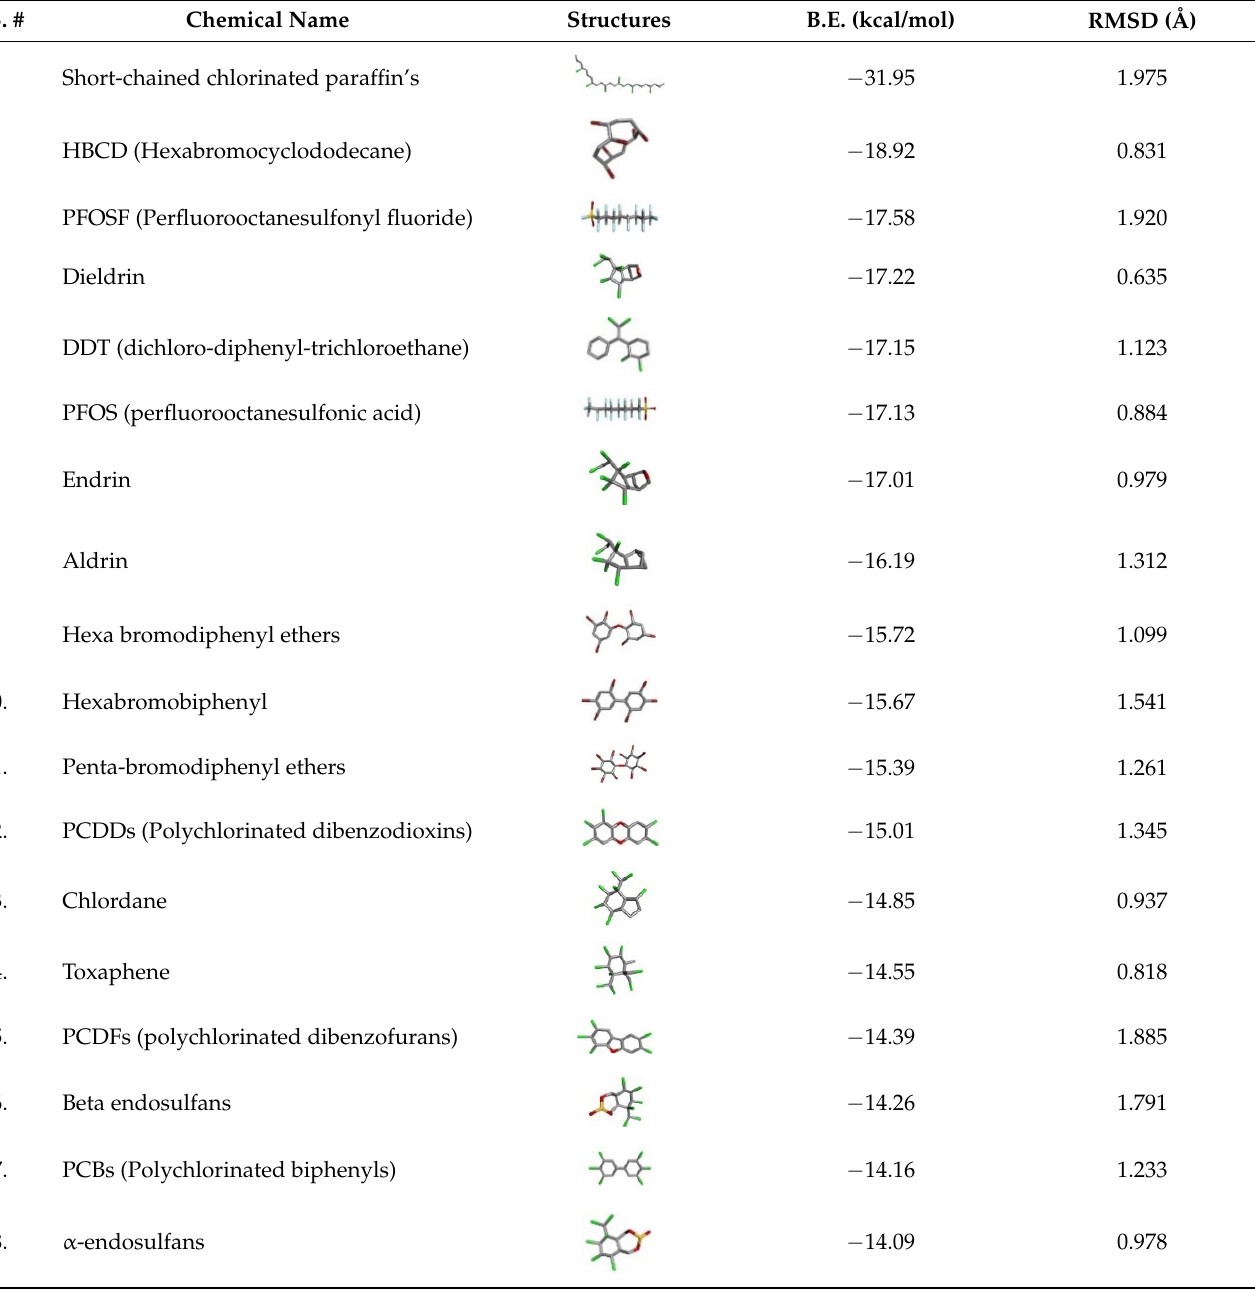
Table 1. Docking of POPs with ER α protein.